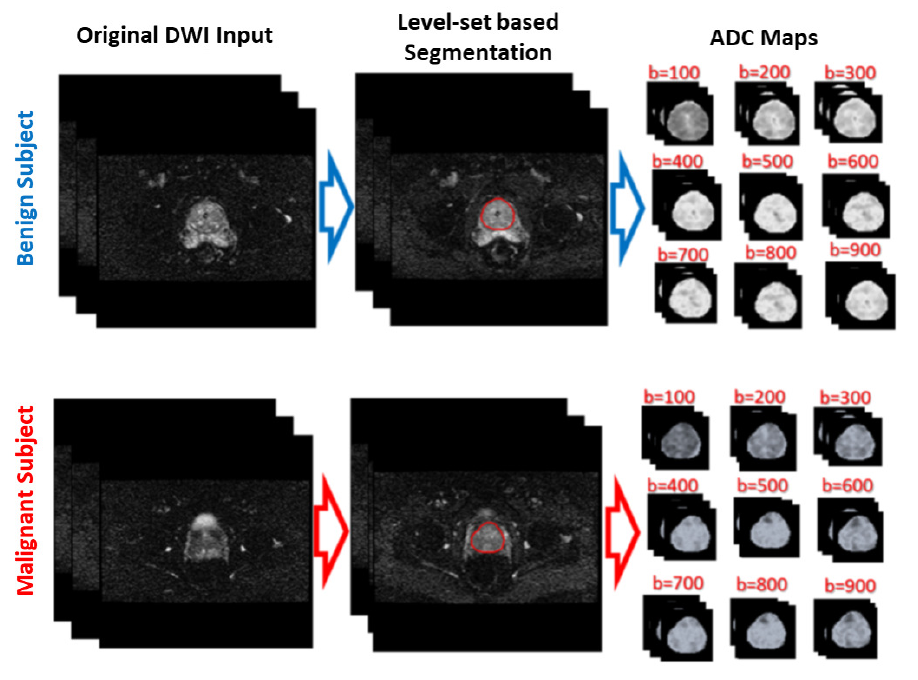
Figure 2. Illustration of the first two processing steps of the proposed framework on two different cases (one benign and one malignant).